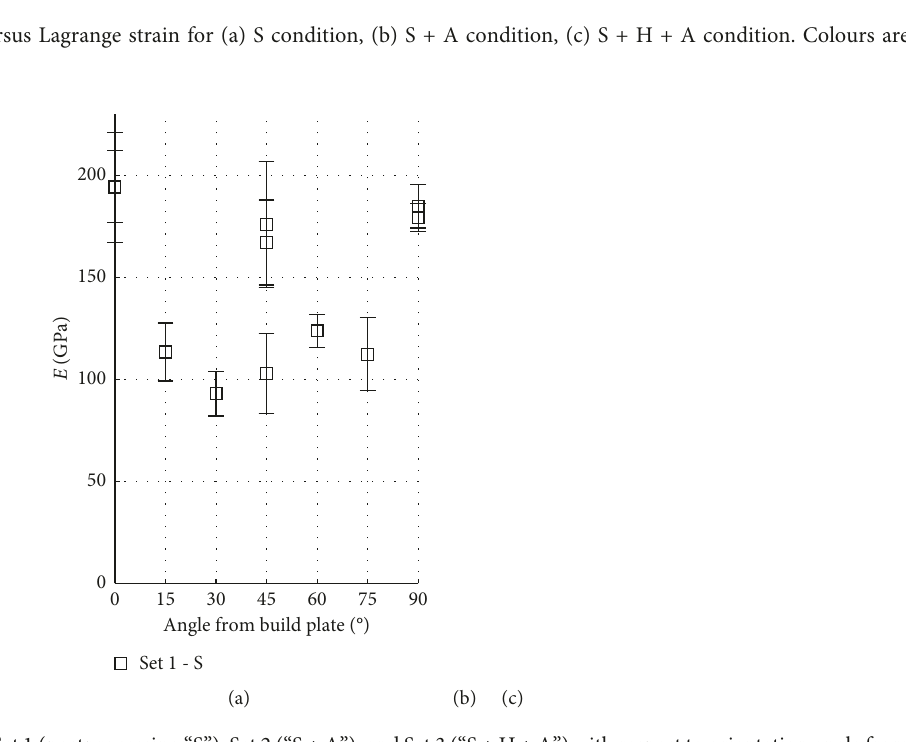
Figure 14: Mechanical properties of Set 1 (postprocessing “S”), Set 2 (“S + A”), and Set 3 (“S + H + A”) with respect to orientation angle from build plate. Points indicate measured values (3 11 in each diagram), while the lines are either 2nd order polynomial fits (a), connecting × lines (b and c) or least square fits (d), indicating the trend.